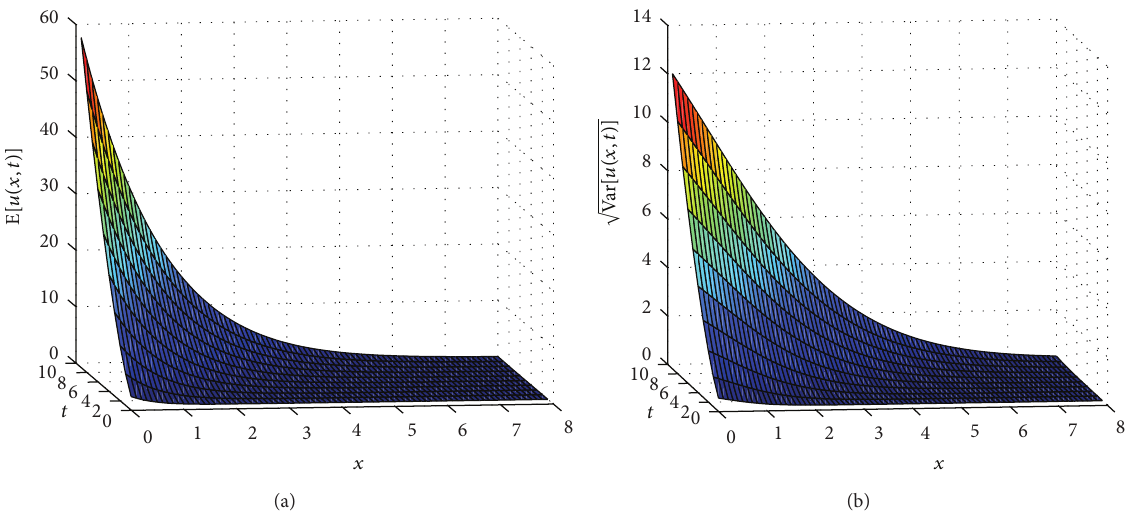
Figure 2: Approximations for the expectation E [𝑢(𝑥,𝑡)] (a), and the standard deviation √ Var [𝑢(𝑥,𝑡)] (b), on the spatial domain 0 < 𝑥 ≤ 8 for some values of time in the interval 1 ≤ 𝑡 ≤ 10 for the data of Example